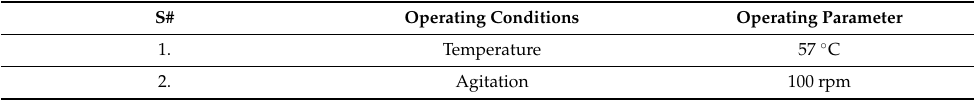
Table 3. The electrodeposition parameters for nickel